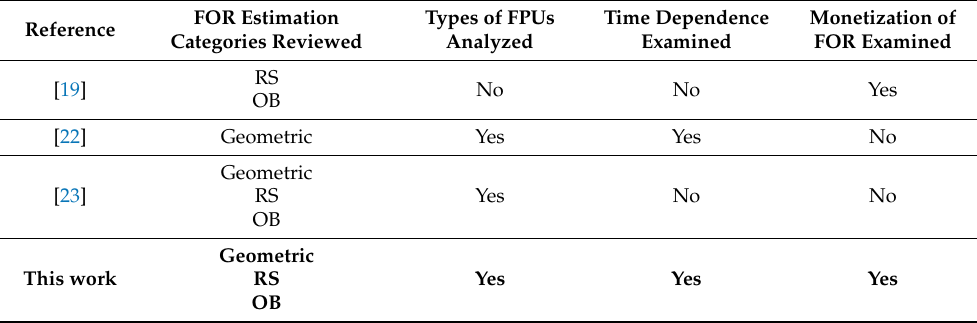
Table 1. A summary of the existing review papers on FOR